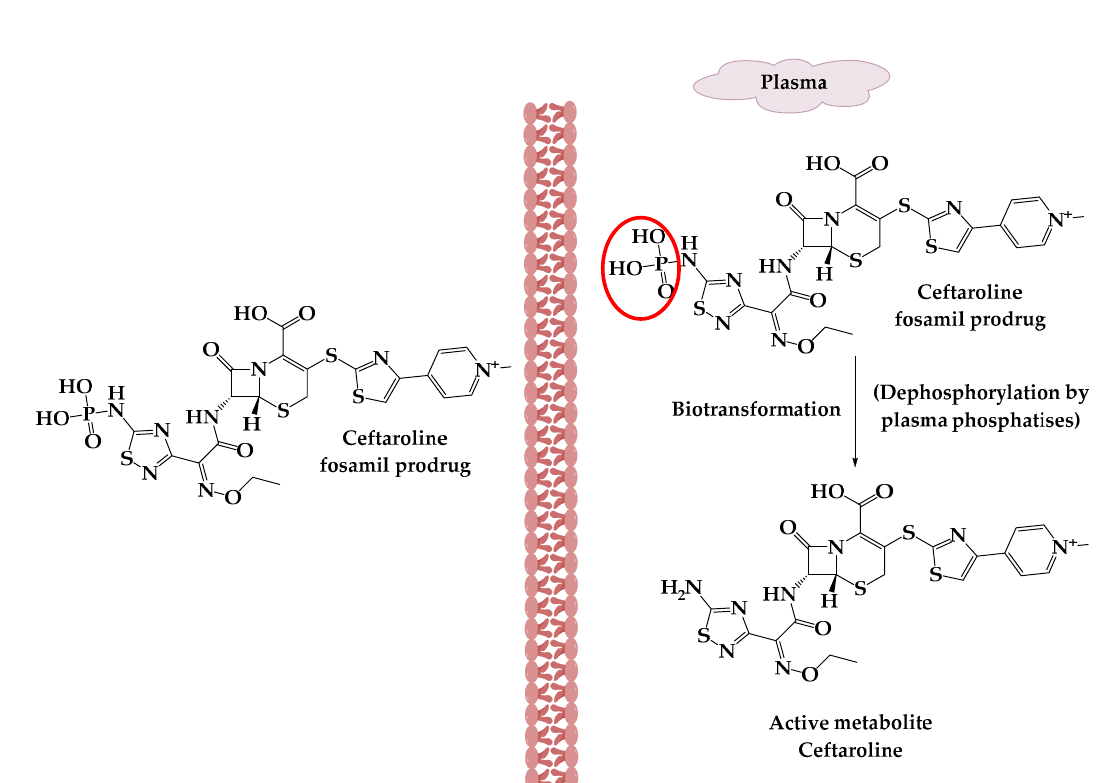
Figure 3. The activation of ceftaroline fosamil prodrug.